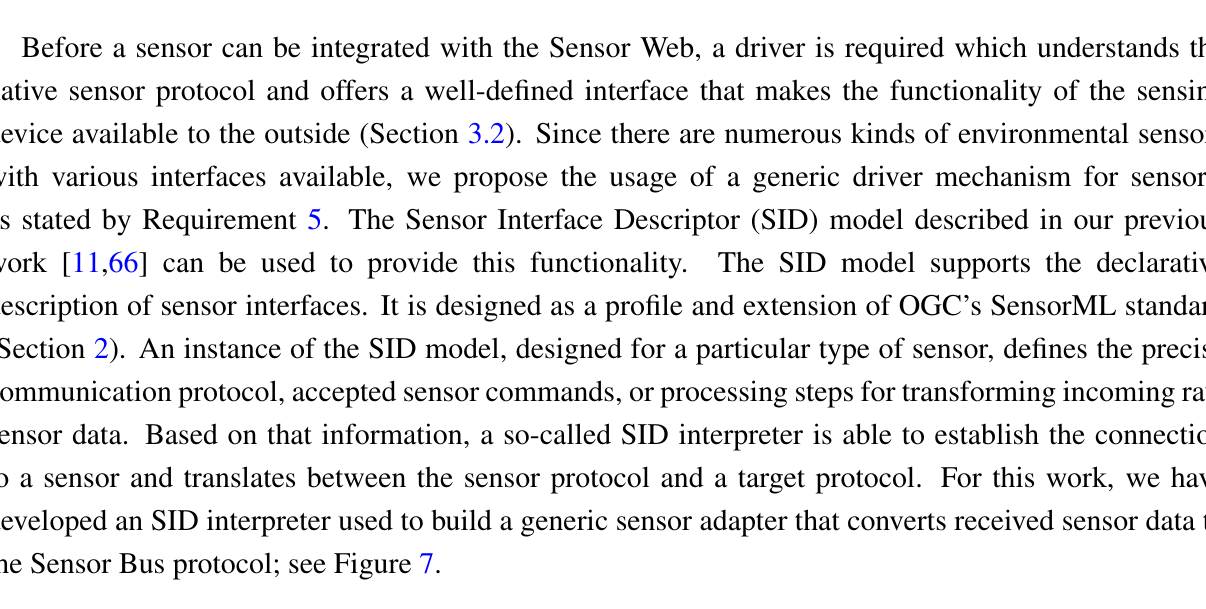
Figure 7. SID interpreter as a sensor adapter for the Sensor